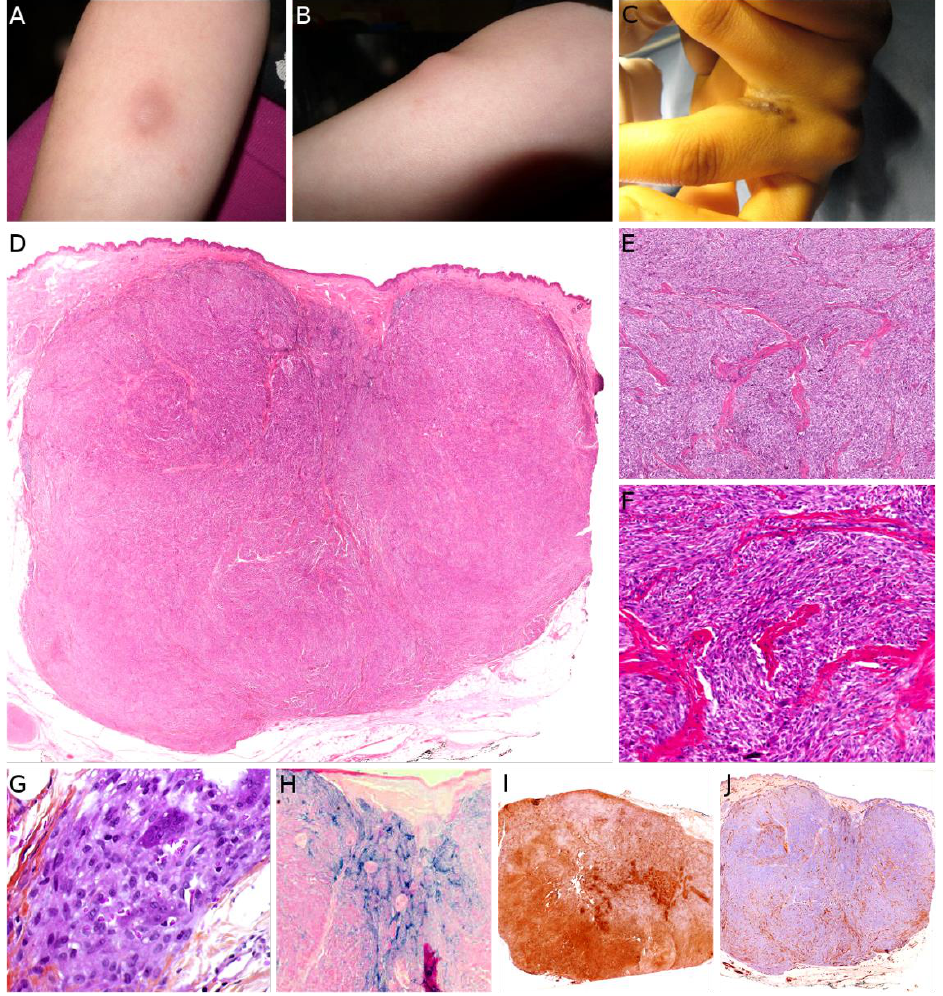
Figure 6. Plexiform fibrohistiocytic tumor: ( A , B ) Subcutaneous nodule of the leg in a girl; ( C ) irreg- ular indurated plaque of the inter-digital space in a teenager; ( D ) dense cellular, subcutaneous, nodular proliferation extending in the dermis (×25); ( E ) plexiform pattern of growth (×100); ( F ) plexiform pattern with some multinucleated giant cells (×100); ( G ) histiocyte-like cells in a fascicle with a mul- tinucleated giant cell (×200); ( H ) hemosiderin deposition (Perls ×25); ( I ) diffuse strong CD163 posi- tivity (×25); ( J ) partial SMA positivity (×25).